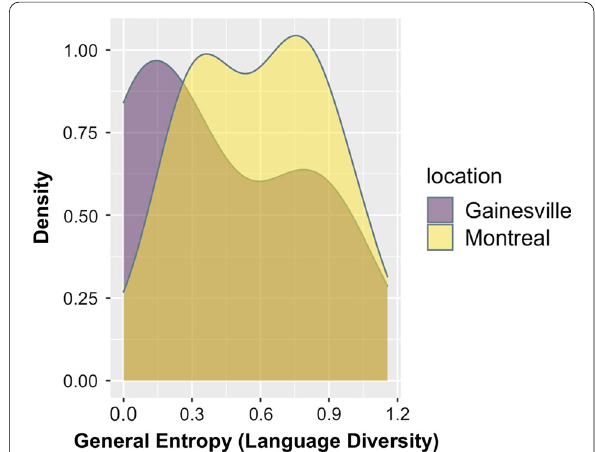
Fig. 1 Overall language entropy distribution in Montreal and in Gainesville